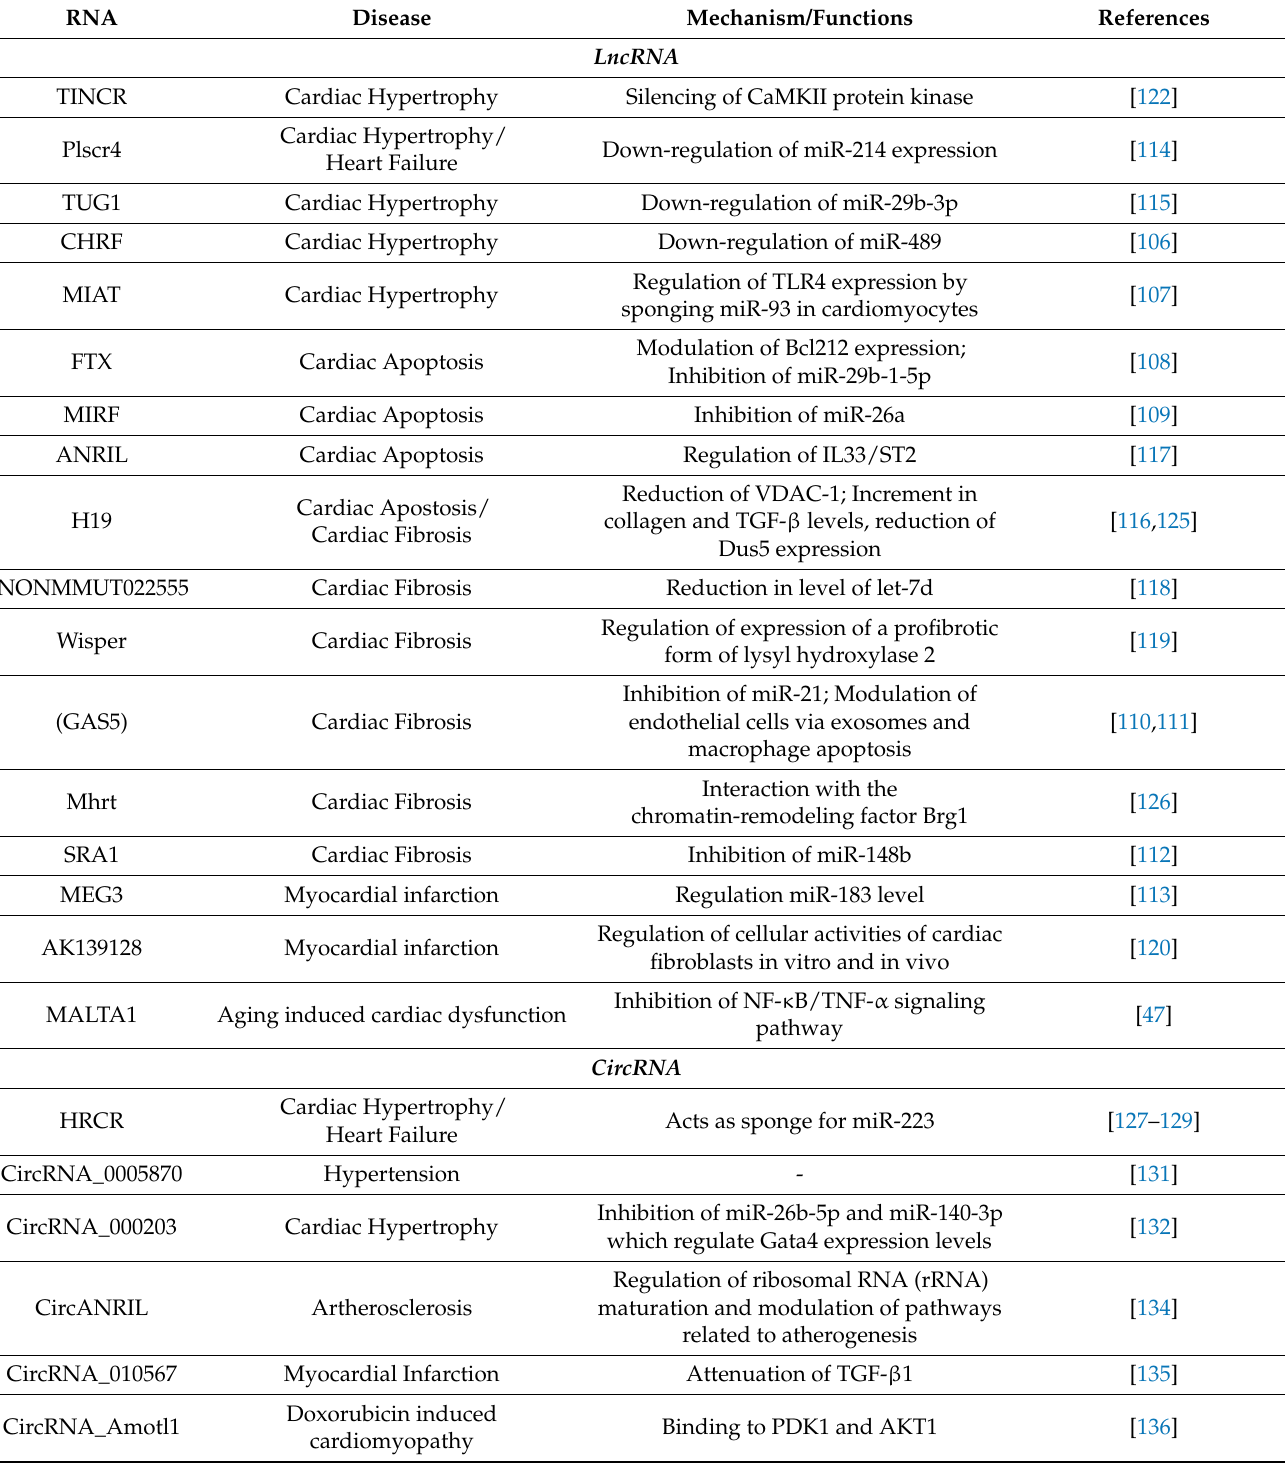
Table 1. RepresentativetableprovidingthelistsofncRNAshighlightedinvariouscardiacpathophysiology.